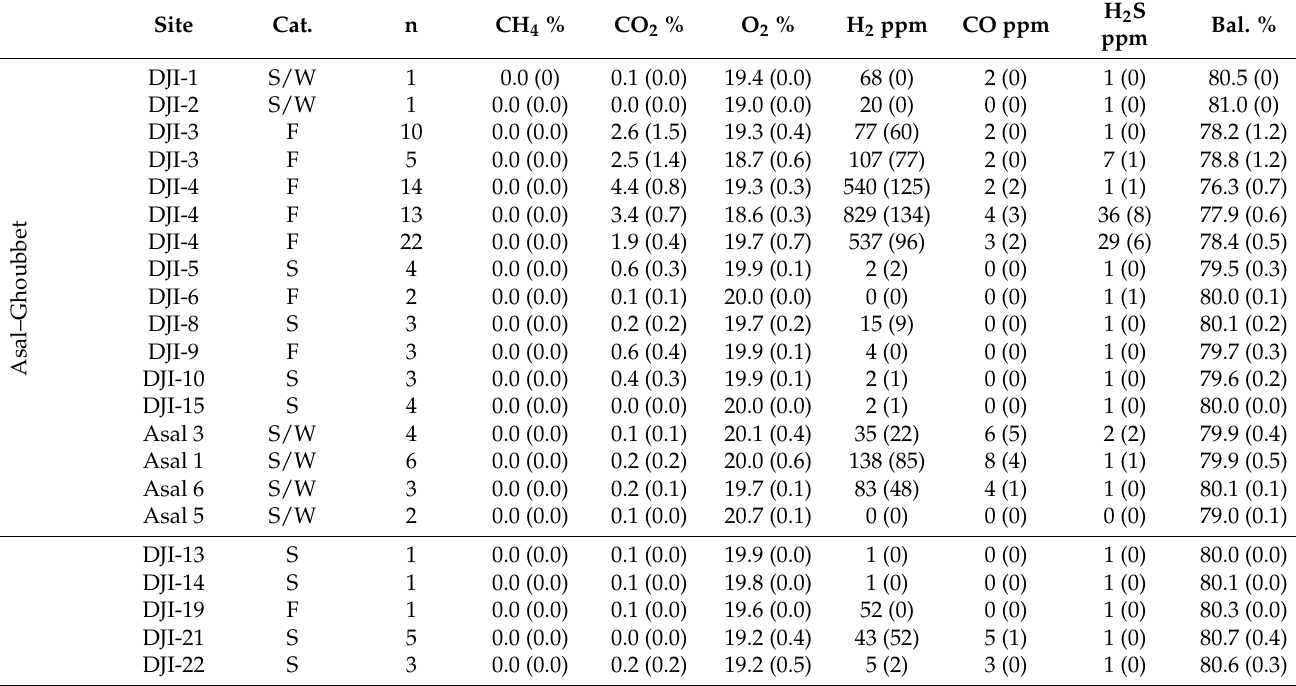
Table 3. Non-corrected gas concentrations from field measurements. F: fumaroles; S: soil; S/W: soil near a geothermal well. (0): Standard deviation between n measurements from the same site. Where this value is 0, the n values were